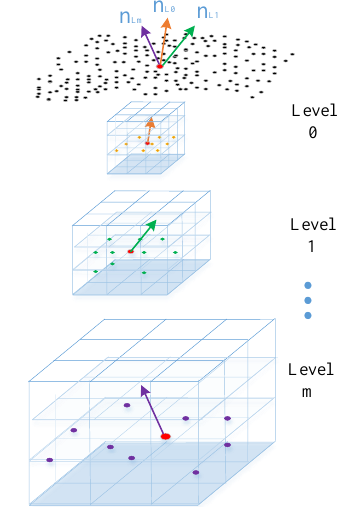
Figure 1 . Illustration of downsampling a point cloud at different scales